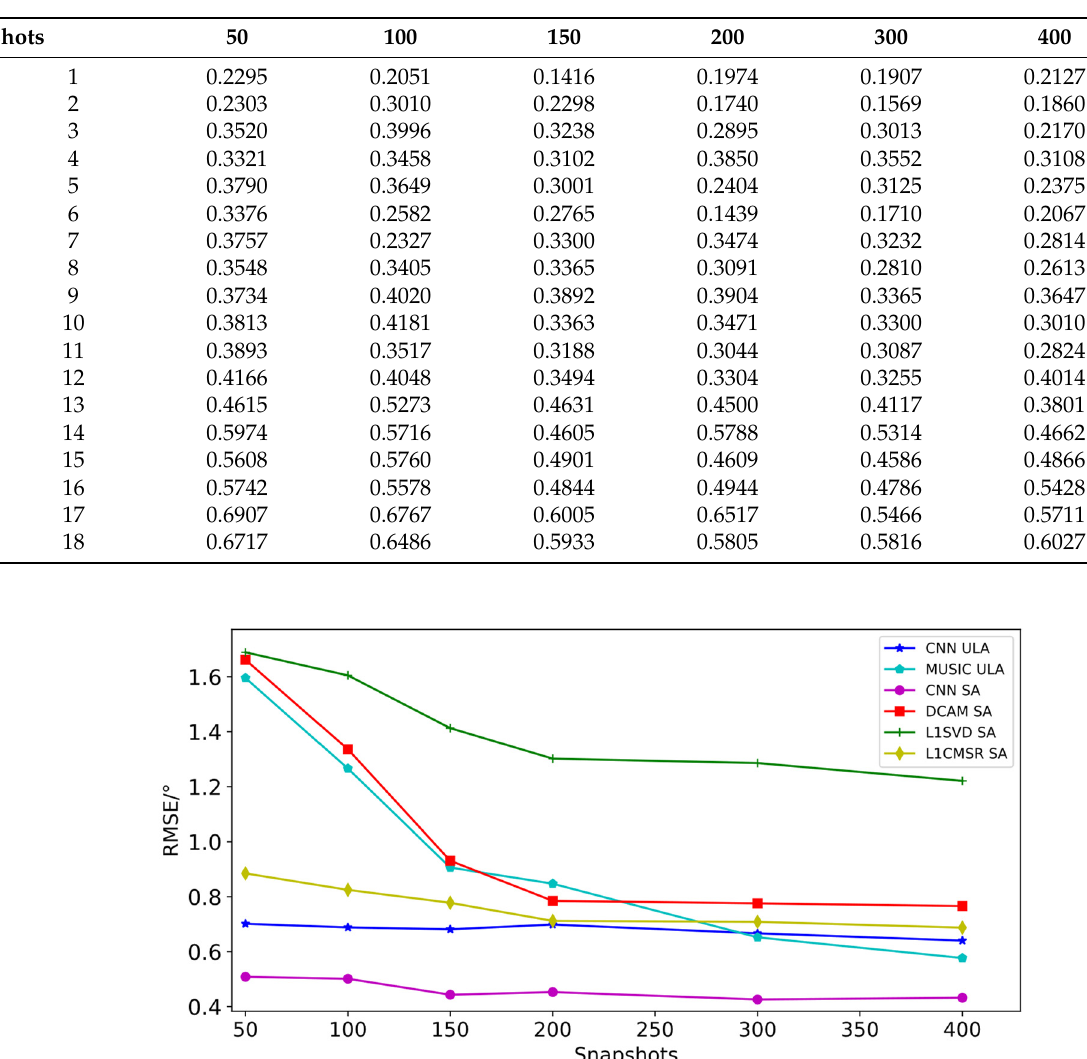
Table 9. RMSE of DOA estimation for sparse array at different snapshots.